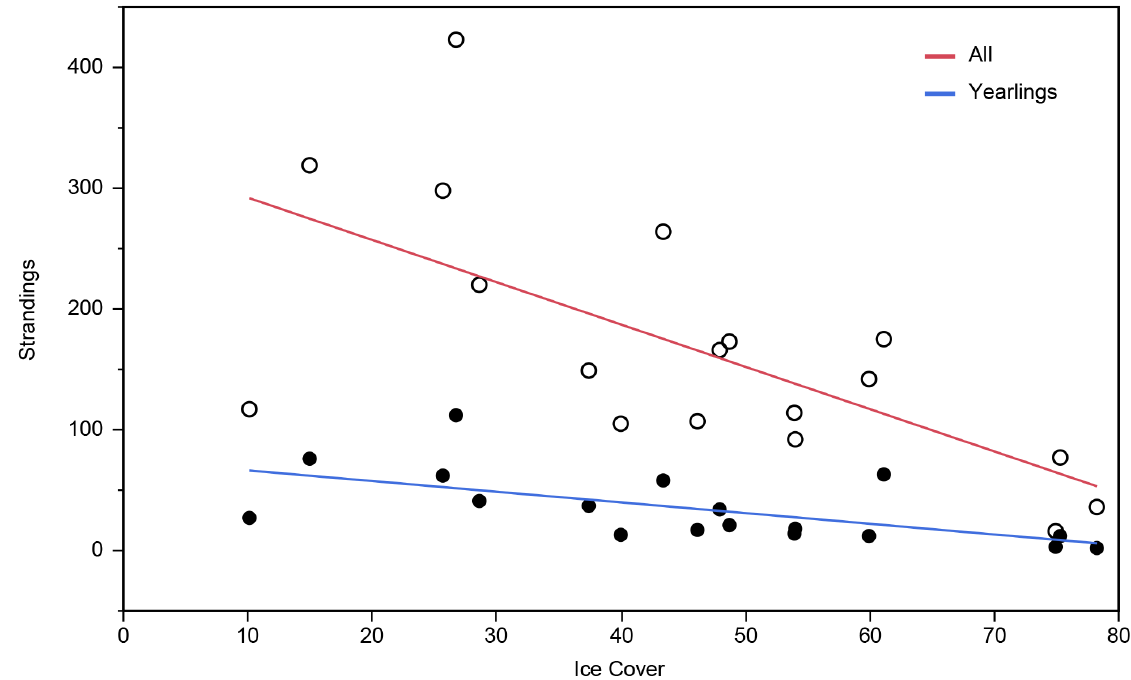
Figure 4. ANCOVA between linear regressions: percent sea ice cover vs. strandings (total and dead yearling strandings). The graph represents the ANCOVA between the linear regression of the present dataset (total strandings) and Johnston et al. [13](dead yearling strandings). Percent sea ice cover and total strandings (open circles and red line) and percent sea ice cover and dead yearling strandings (solid circles and blue line).